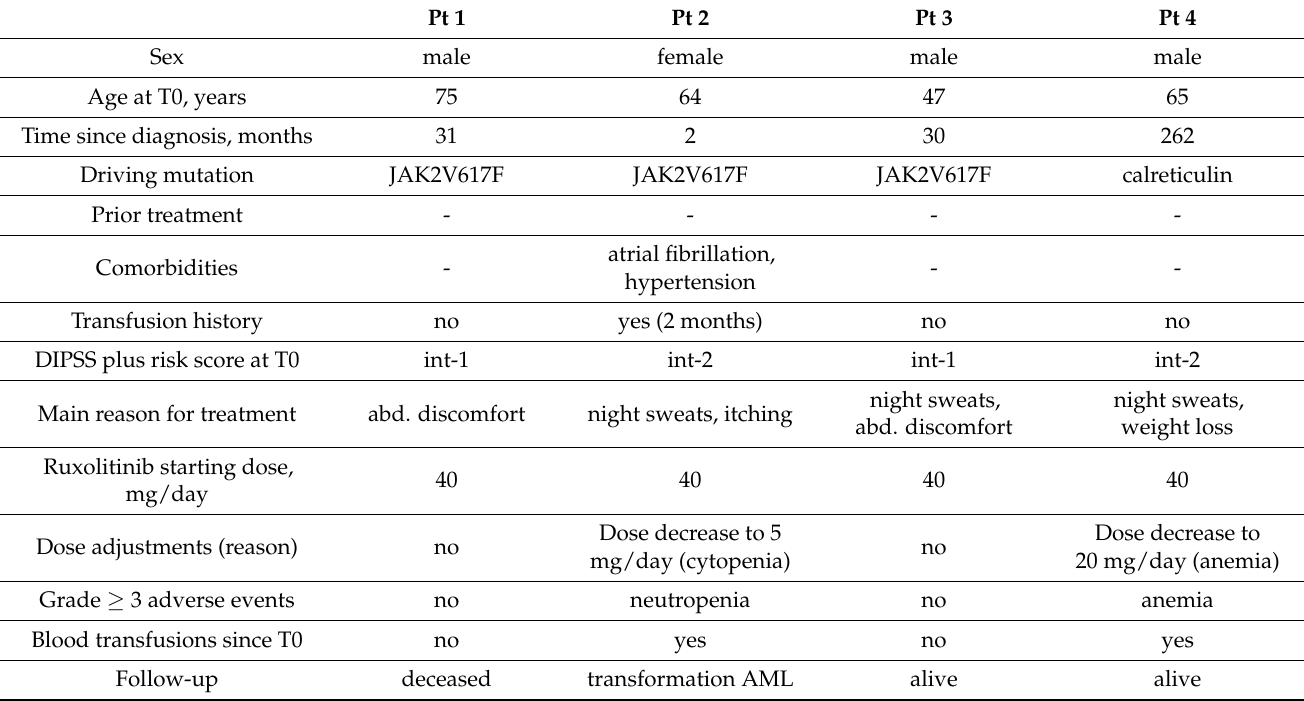
Table 2. Patient, disease, and treatment